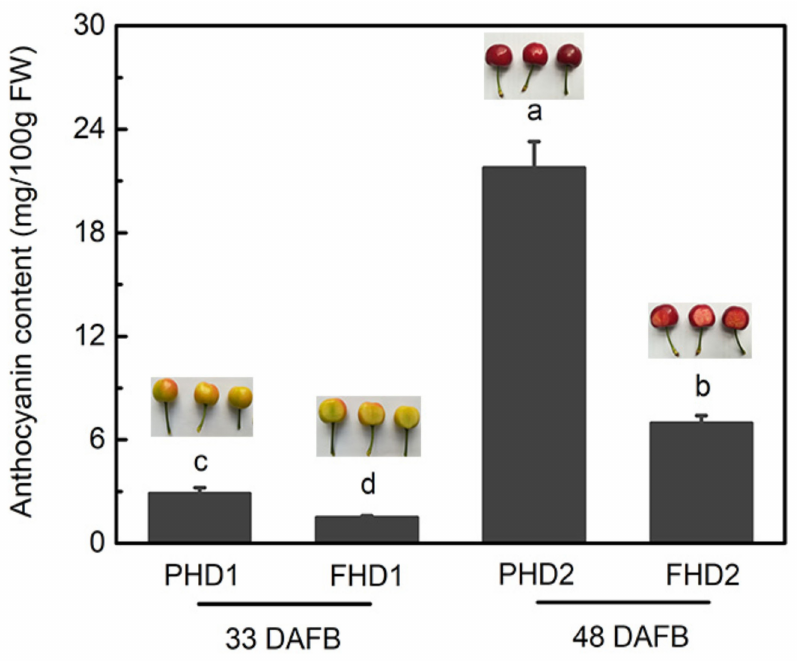
Figure 1. Coloration and anthocyanin content during fruit development and in different parts of sweet cherry cultivar ‘Hong Deng’. Samples were analyzed at 33 days after full bloom (DAFB) and at 48 DAFB. PHD: peel of ‘Hong Deng’ sweet cherry, FHD: flesh of ‘Hong Deng’ sweet cherry. The error bars represent SEs from three replicates. The different letters above each column indicate significance at p < 0.05 according to Tukey’s test.